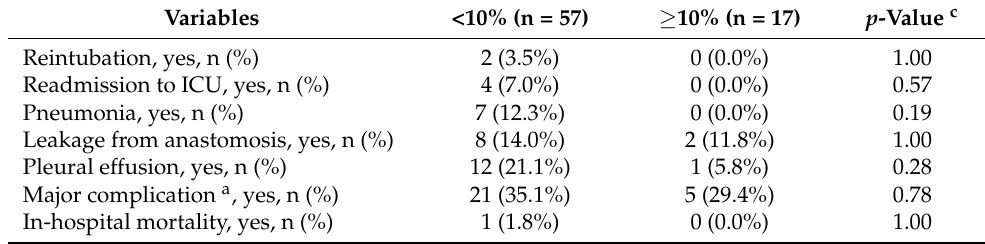
Table 4. Surgical outcomes of the two study groups based on ICG test